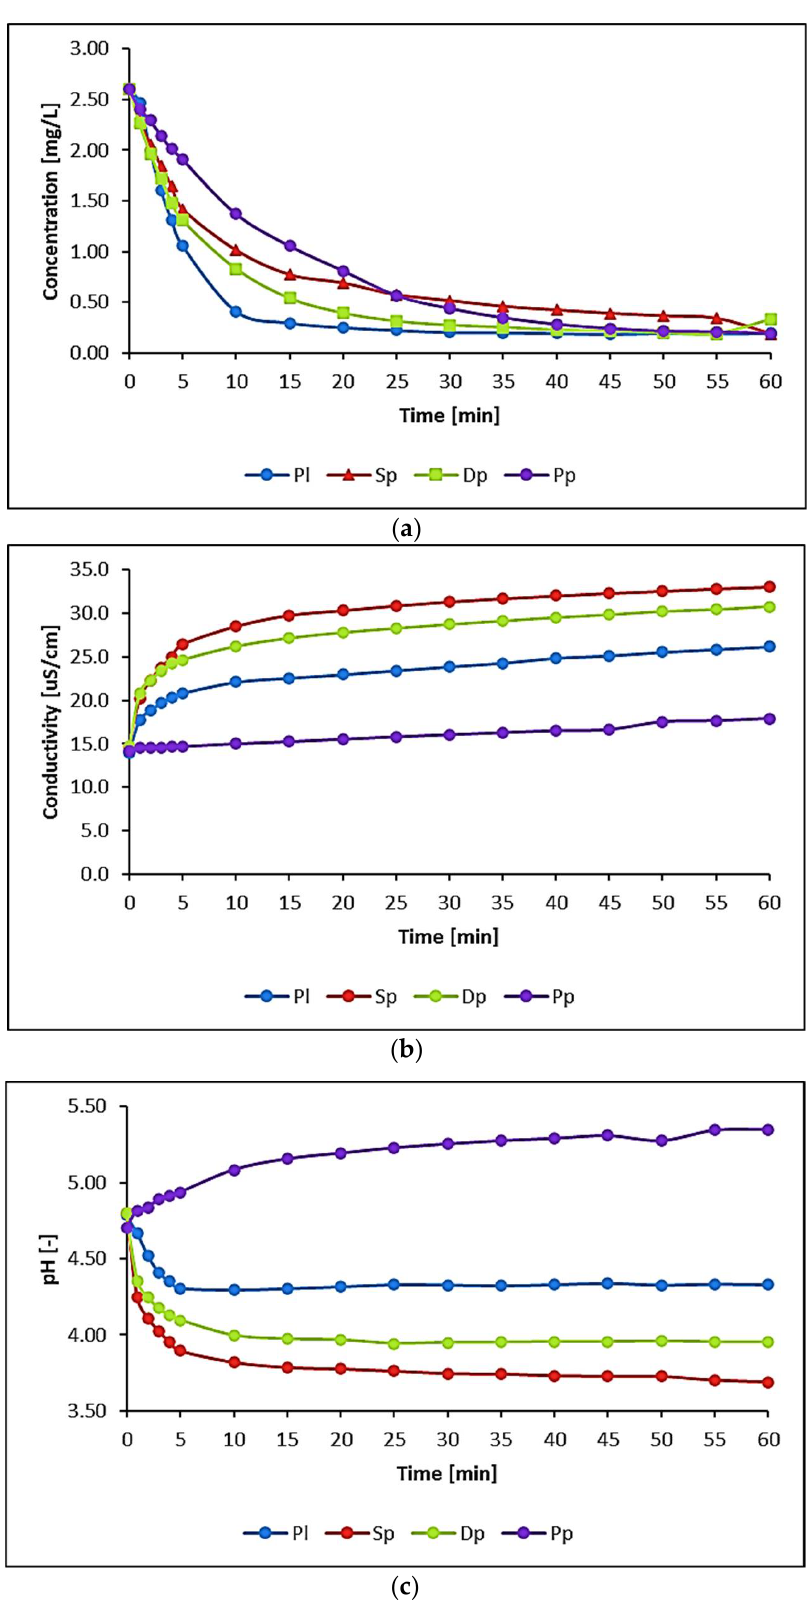
Figure 2. Physicochemical changes in Cu solution during the accumulation process on moss gametophytes and algae: ( a ) its concentration; ( b ) conductivity; ( c ) pH (Pl— P. schreberi , Sp— S. fallax , Dp— D. polysetum and Pp— P. palmata ).